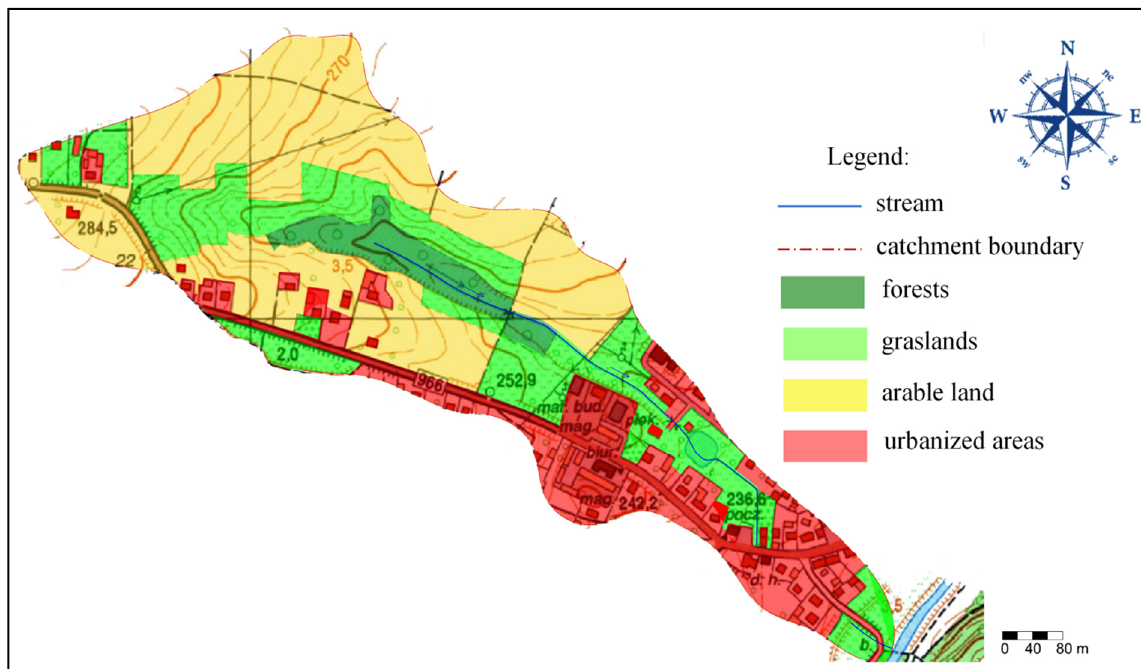
Figure 4. Land use structure in the stream catchment.